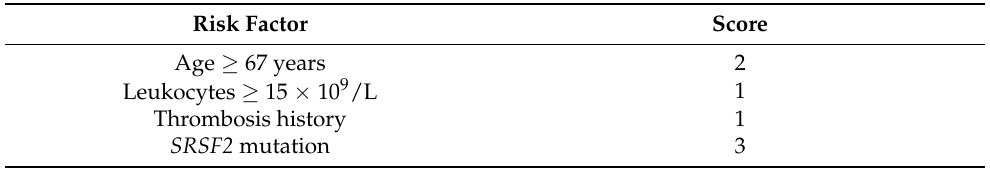
Table 3. Stratification of risk of survival in polycythaemia vera according to the Mutation-enhanced International Prognostic Scoring System (MIPSS-PV) (adapted from